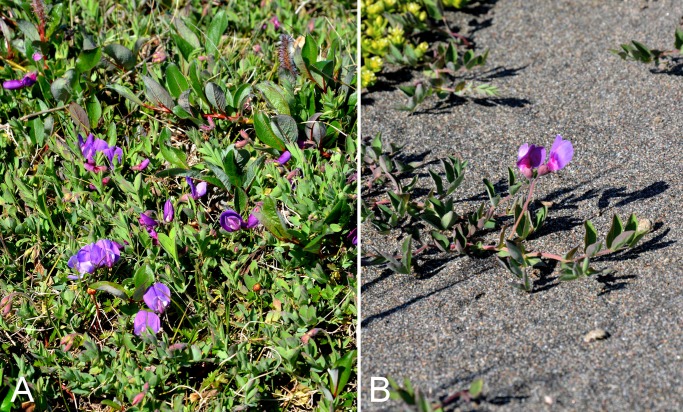
Lathyrus japonicus.(A) Habitat, Saarela et al. 3713. (B) Habit, Saarela et al. 3713. Photographs by P. C. Sokoloff.